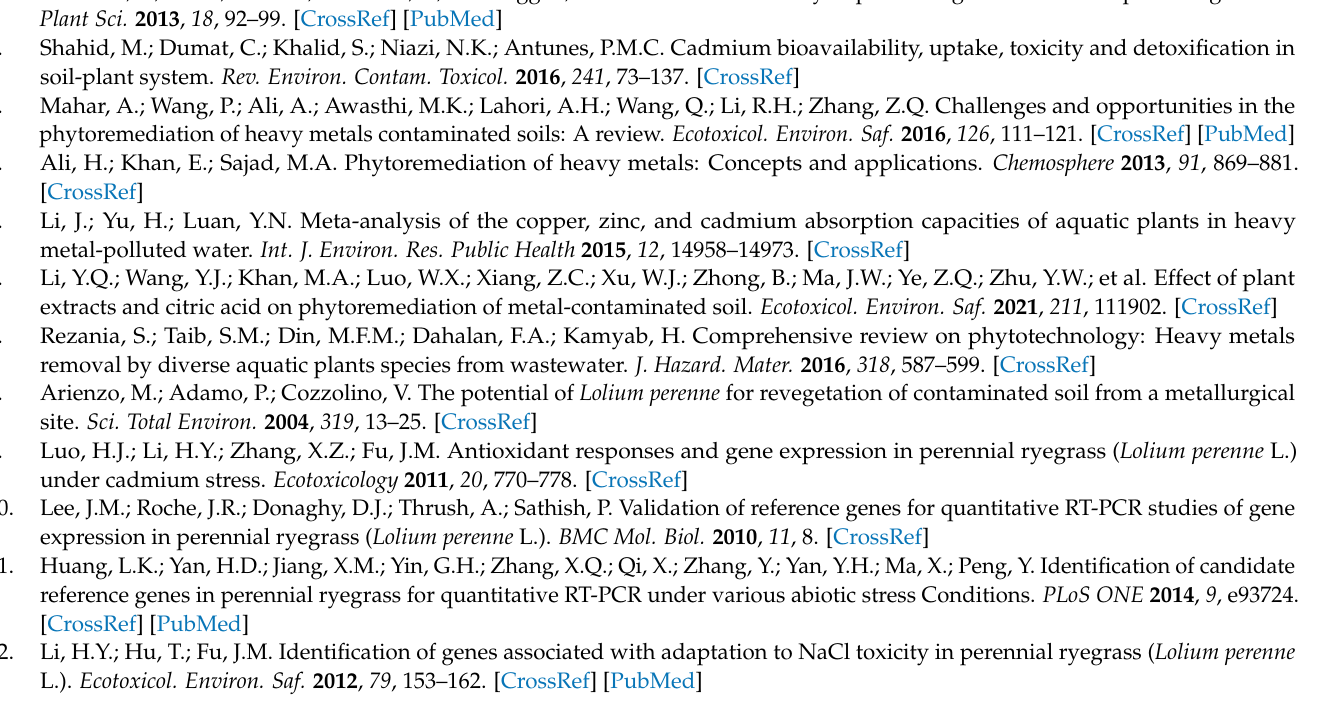
statistics, Table S5: Optimized transcriptome assembly details, Table S6: Alignment and quality analysis of transcriptome data, Table S7: Unigenes annotation results from six databases and Table S8: Primers used for